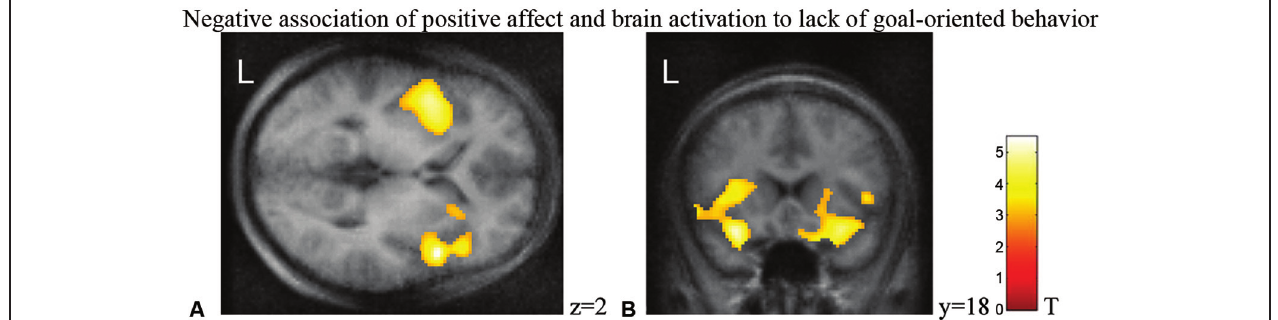
association of brain reactivity to lack of goal-oriented behavior in (A) the insula and (B) the amygdala. Negative association of PA and brain activation to lack of goal-oriented behavior.